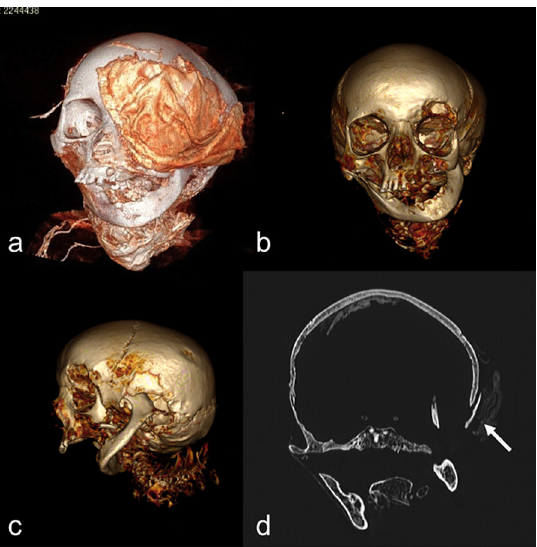
Fig 8. VR reconstructions (a,b,c) and coronal MPR reconstructions (d) of skull. Large bandage on the left orbit to cover a large osteolytic lesion of the left orbit with large erosive phenomenon. The jaw presented an amputation of the left ascending tract at approximately two thirds. A lamellar bony structure was present on the external superior margin of the wide discontinuity of the skull likely due to reparative process (arrow).